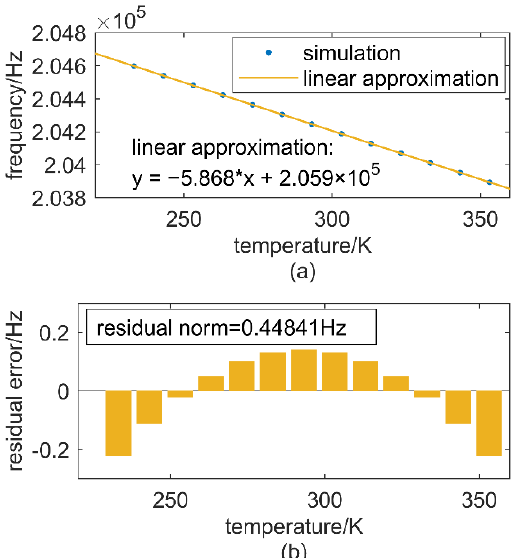
Figure 2. ( a ) frequency drift caused by Young’s modulus and thermal expansion with temperature and linear approximation, ( b ) residual error between simulation and linear approximation.